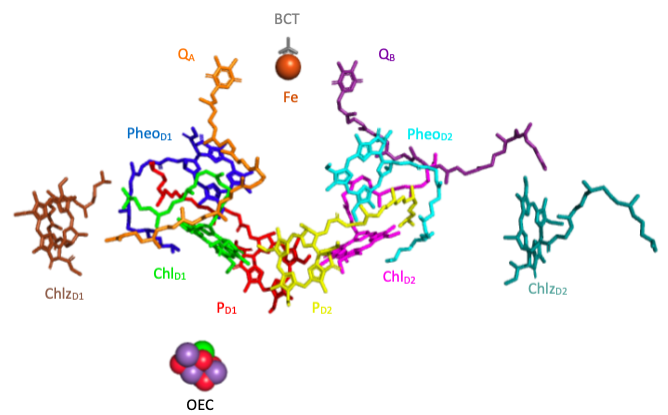
Figure 1. Pigments and plastoquinones in the D1 and D2 proteins from 3WU2 provided by the